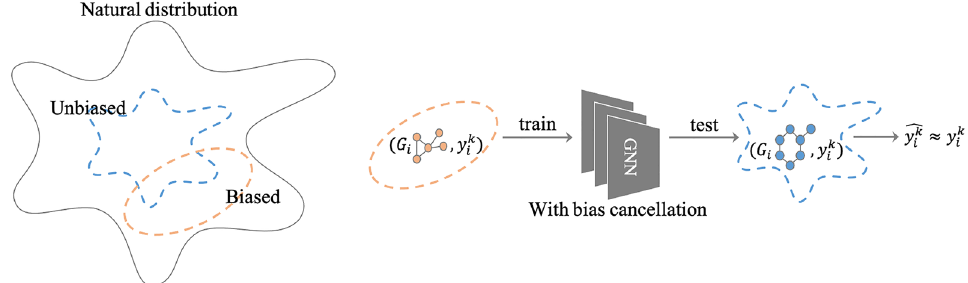
Figure 1. Main aim of our study. The left-hand figure shows the biased and unbiased distribution compared with the natural universe distribution of a chemical domain or sub-domain. The right-hand figure shows the proposed methods to train GNNs for chemical property prediction. Our aim was to apply bias cancelling techniques for GNNs to achieve significantly lower errors (i.e., MAE) when tested on a randomly sampled test dataset, whose distribution is similar to nature. G is the molecular graph, and y k is the value of the k -th chemical